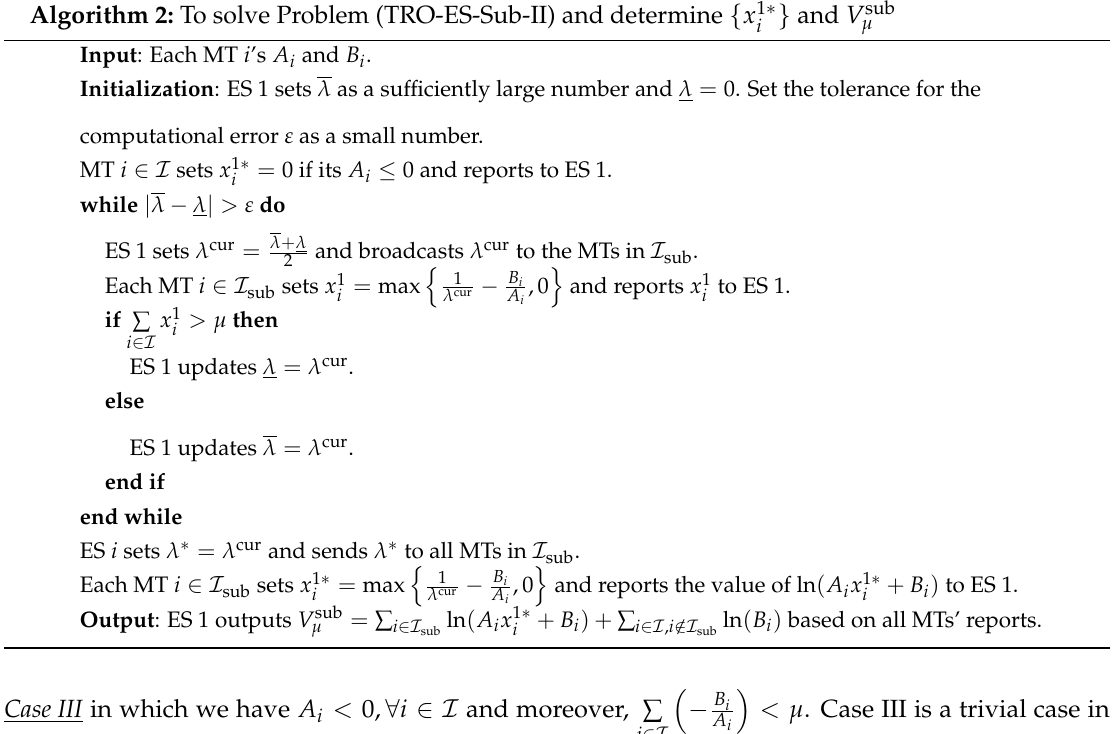
Algorithm 2: To solve Problem (TRO-ES-Sub-II) and determine { x 1 ∗